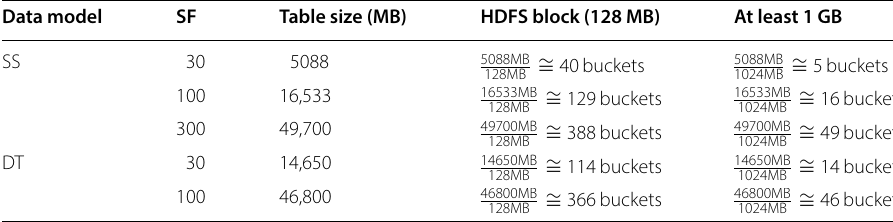
Table 3 Definition of the number of buckets (for bucketing only) Data